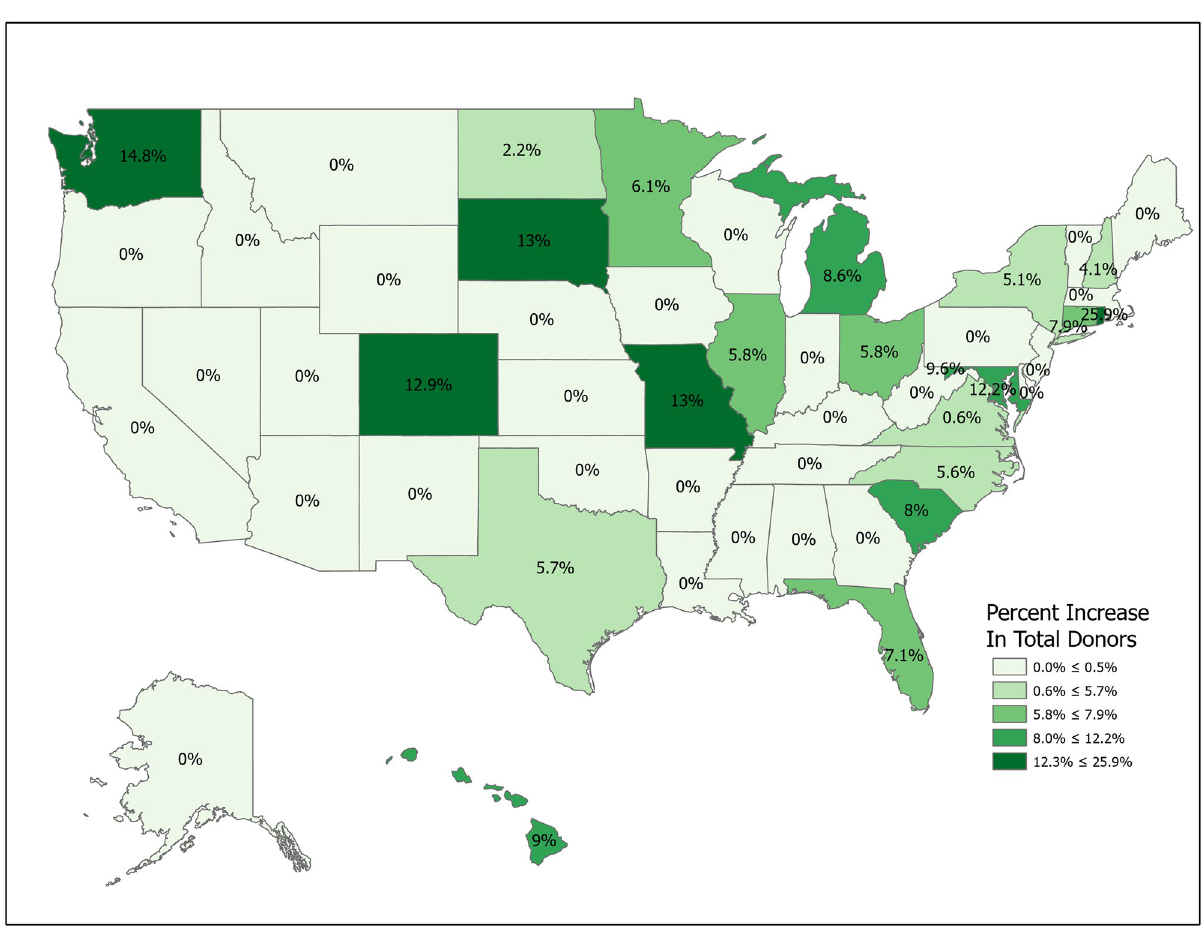
Fig 10. Simulation 4: Target states with low non-registered donor authorization rates ( q 2 ). Data come from Table 6. Maps created by ArcGIS Pro, URL: https://www.esri.com/en-us/arcgis/products/arcgis-pro/overview. Base Map: World Light Gray Base, URL: https://services.arcgisonline.com/